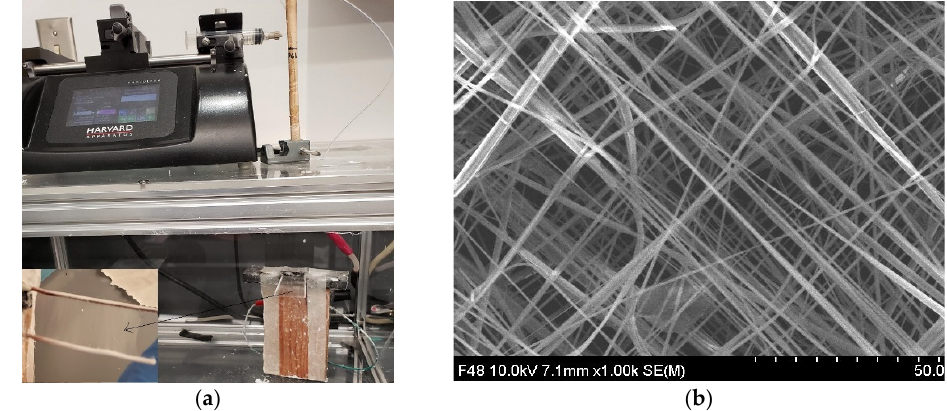
Figure 4. ( a ) Fabrication of random 24 layers of PCL fibers for coating the gels using the electrospinning process. Inset picture shows the collected single layer of aligned fibers between two-wires in the electrospun machine which was used to fabricated 24 layers of PCL fiber mesh. ( b ) SEM image of 24 layers of PCL fiber mesh.